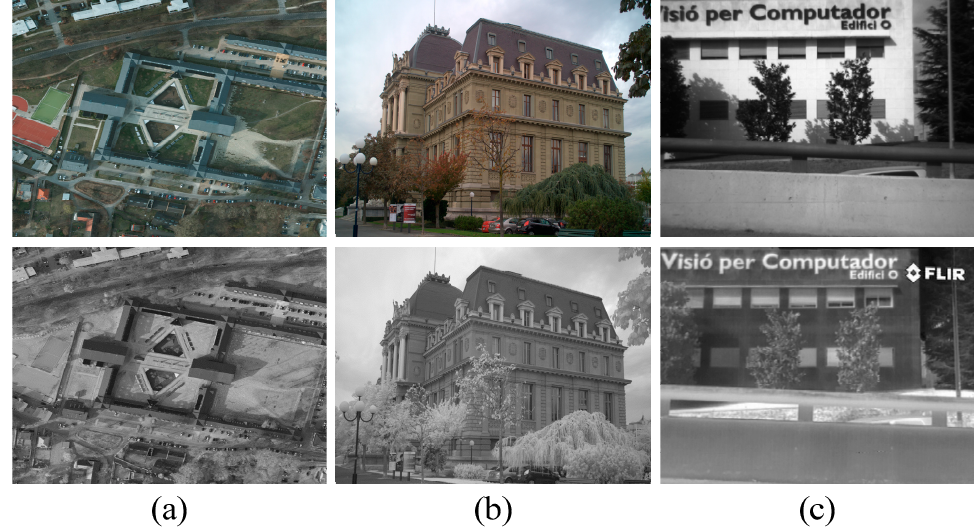
Figure 6. Samples of the multispectral image pairs from three datasets. ( a ) Potsdam (VIS/NIR) dataset, ( b ) EPFL (VIS/NIR) dataset, and ( c ) CVC (VIS/LWIR) dataset.